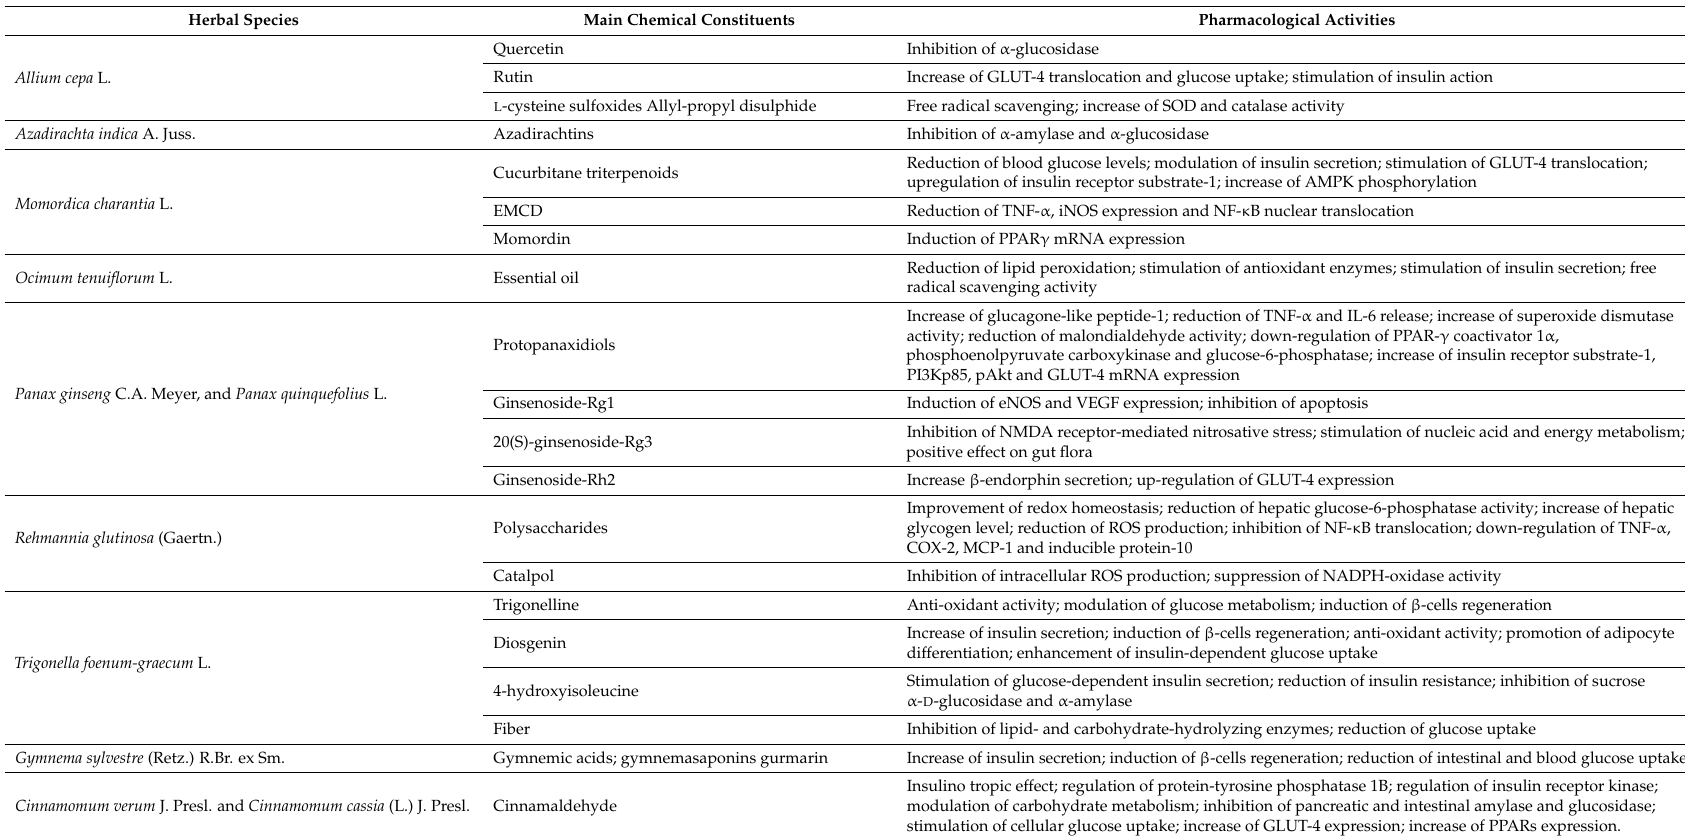
Table 2. Pharmacological activities of the main chemical constituents of hypoglycemic medicinal